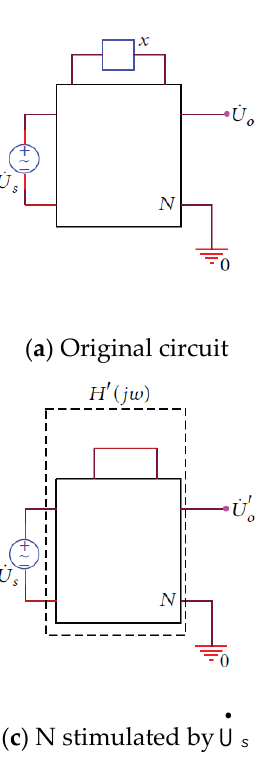
Figure 1. The procedure of circle modeling.